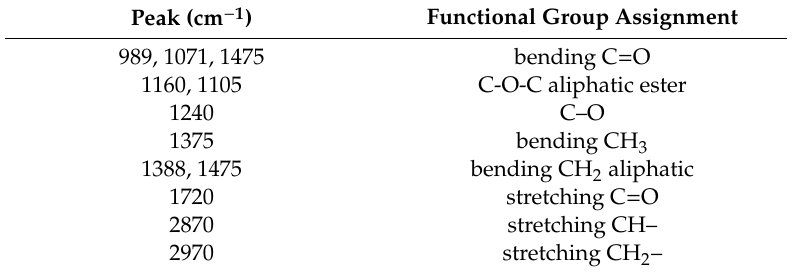
Figure 4. FTIR spectra of ( a ) sample Red, ( b ) sample Red-N, ( c ) sample Brown and ( d ) sample Brown-N as a function of the degradation cycles. Table 4. Main IR transmission bands of analytical interest identified for all the samples.